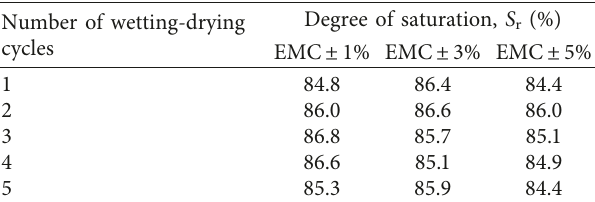
Figure 8: Variations of electrical resistivity with degree of saturation. Table 2: Actual degree of saturation of specimens at EMC.